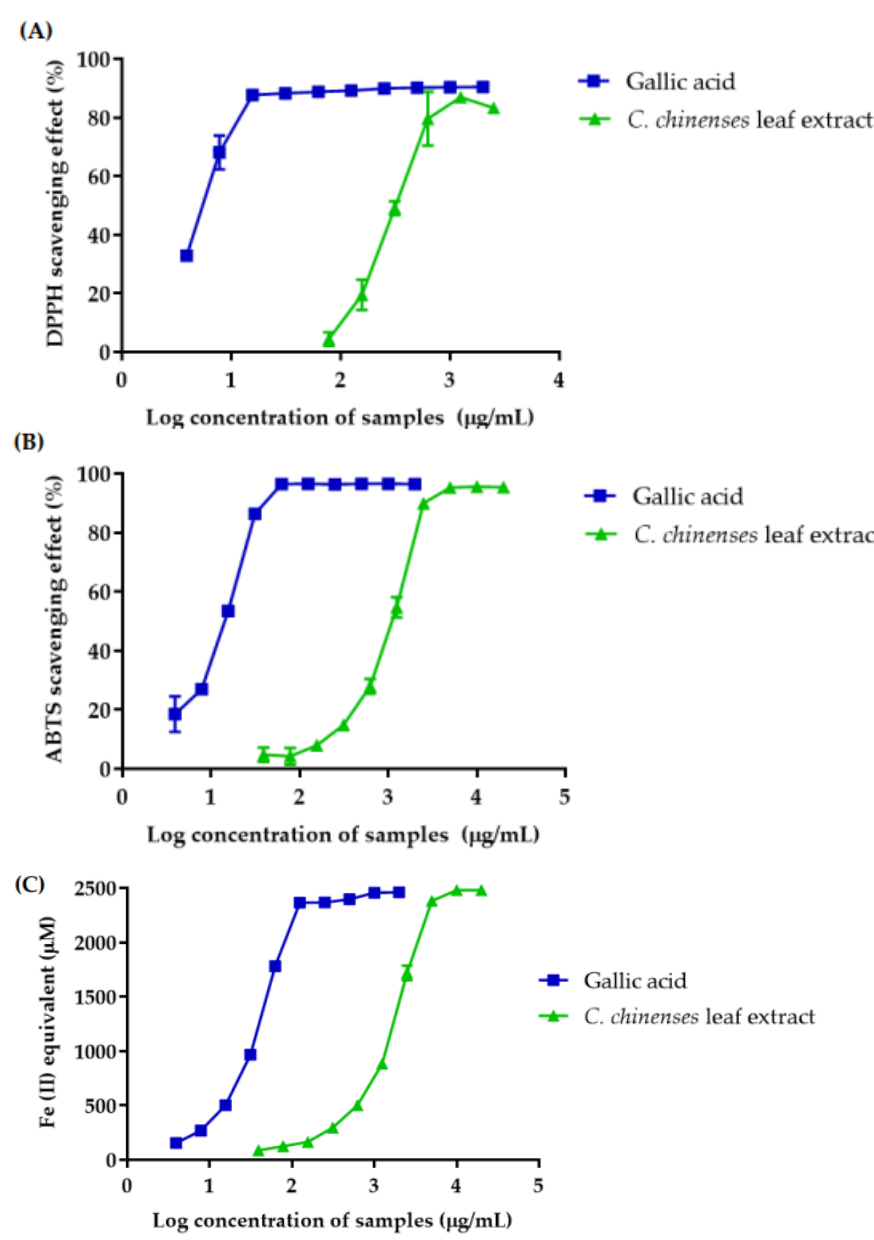
Figure 2. The antioxidant activity of gallic acid and C. chinense leaf ethanolic extract determined by ( A ) DPPH free radical scavenging assay; ( B ) ABTS free radical scavenging assay and ( C ) ferric reducing antioxidant power (FRAP) of C. chinense leaf extract. Data are shown as the mean ± SD ( n = 3).